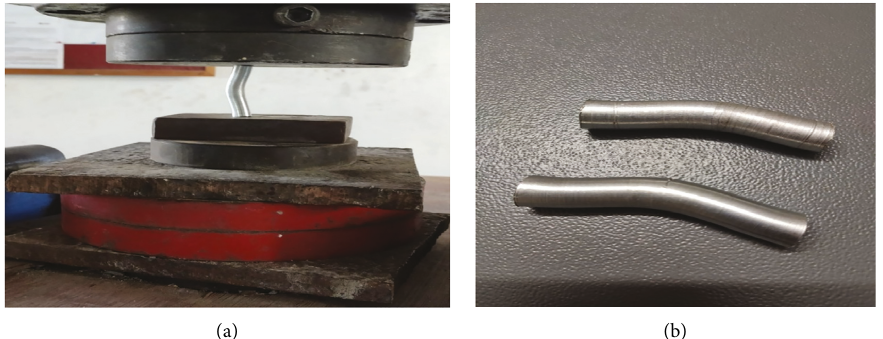
Figure 16: (a) Specimen during testing. (b) Tested specimen.